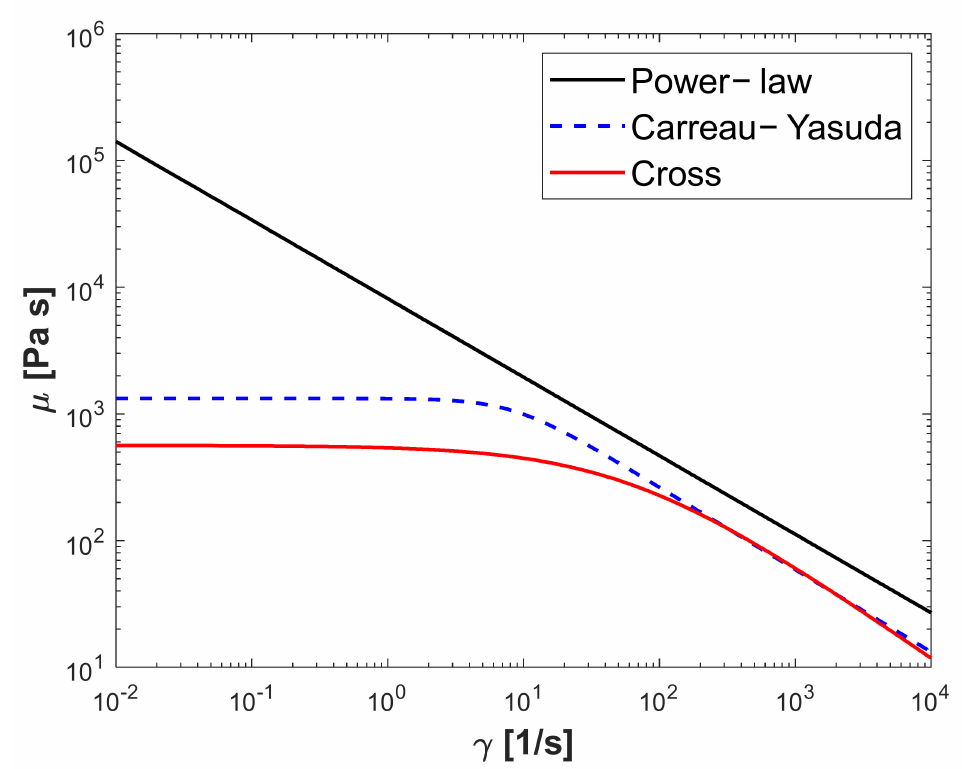
Figure 10. Shear rate versus the apparent viscosity of polypropylene for power-law, Cross and Carreau–Yasuda rheology models